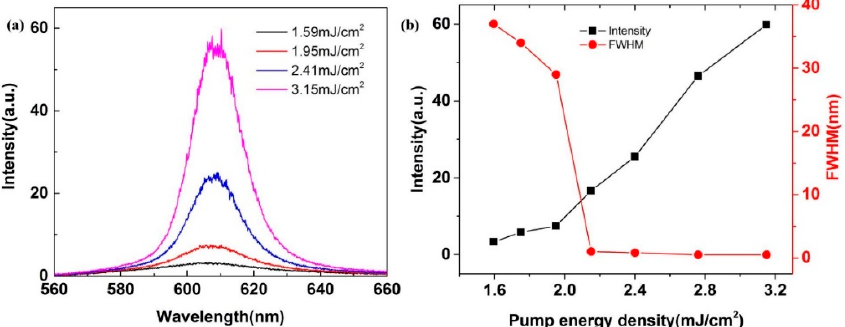
Figure 3. ( a ) Evolution of the emission spectrum from the DDNLC sample as a function of the pump energy density. ( b ) The peak intensity and FWHM of the emission spectrum from the DDNLC sample as a function of the pump energy density.